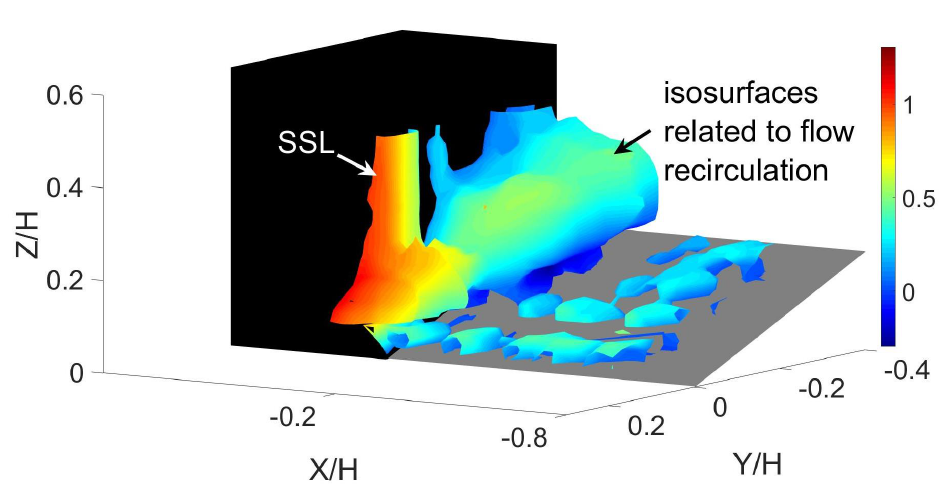
Figure 5. Dimensionless time-averaged vertical vorticity fields at ( a ) Z = 0.37 from the channel bed. ( c ) Z H